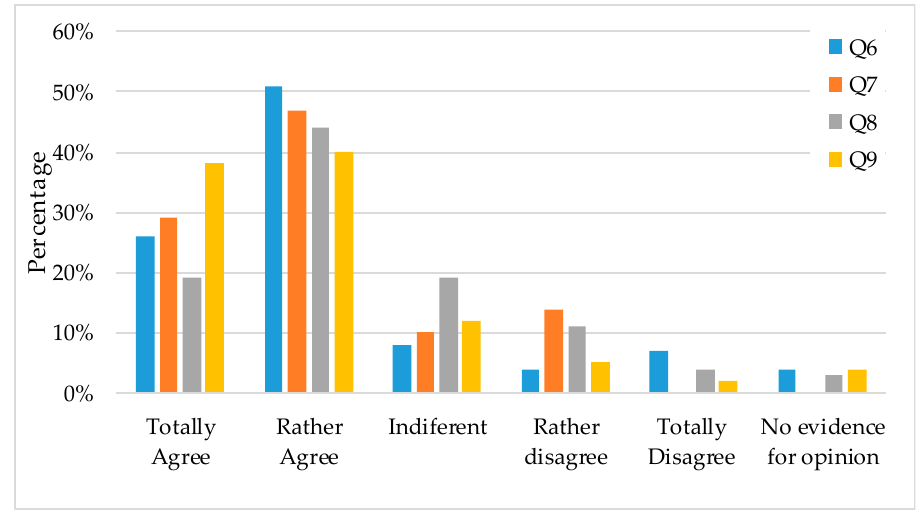
Figure 7. Survey to analyze the vertical coordination between subjects that are located on different courses and levels (Bachelor’s or Master’s degree).